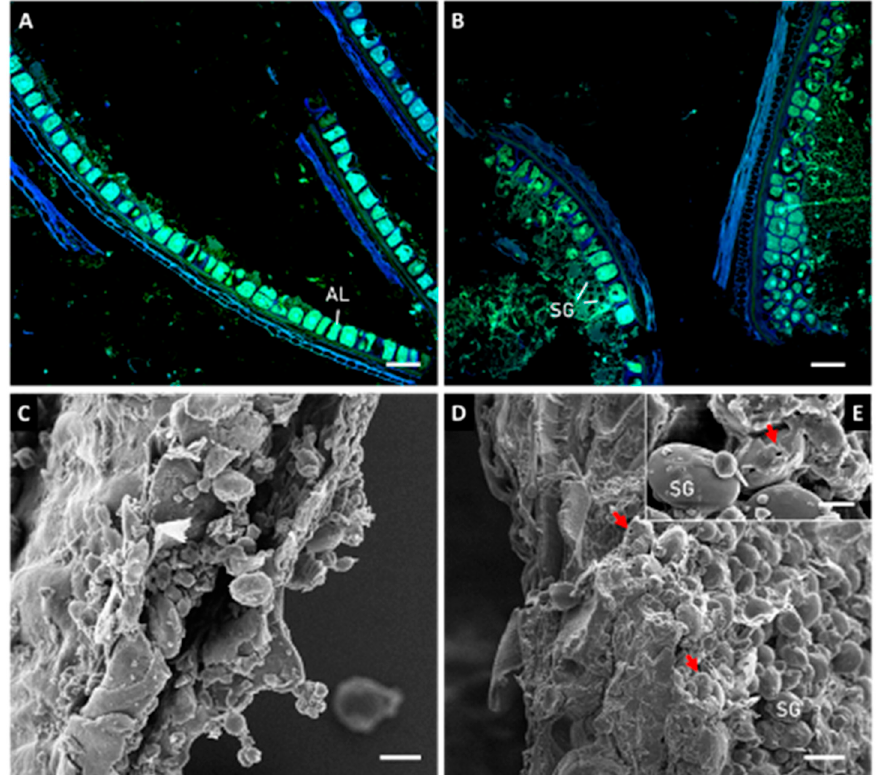
Figure 2. Confocal laser scanning microscopy ( A , B ) and scanning electron microscopy ( C–E ) of bran